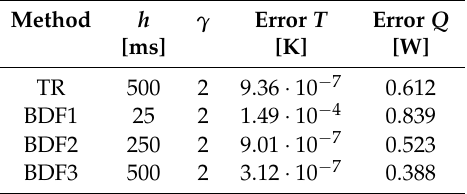
Table 17. Synchronous motor: Low-precision configuration of the DAE integration methods.